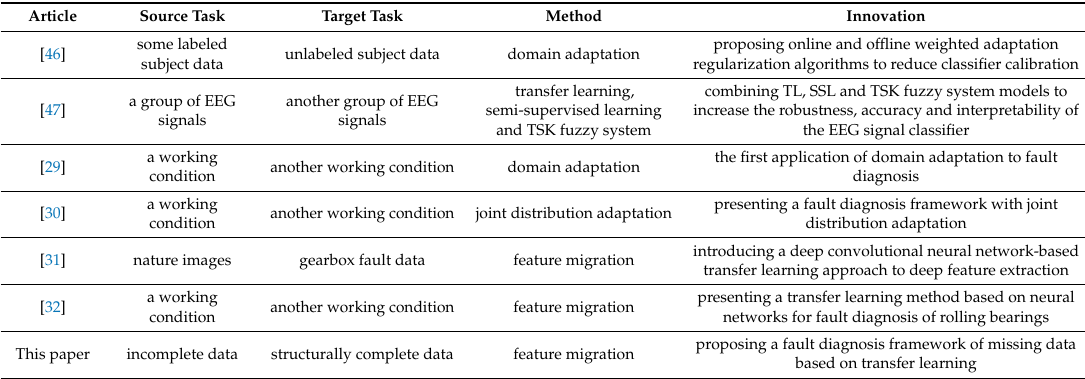
Table 1. A comparison between the relevant literature and this